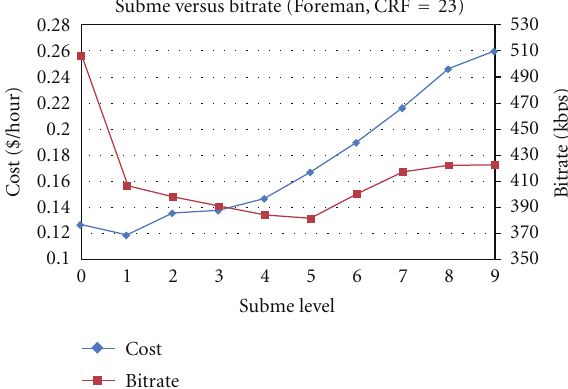
Figure 12: Bitrate and cost with increasing Subme levels (Foreman, crf = 23).